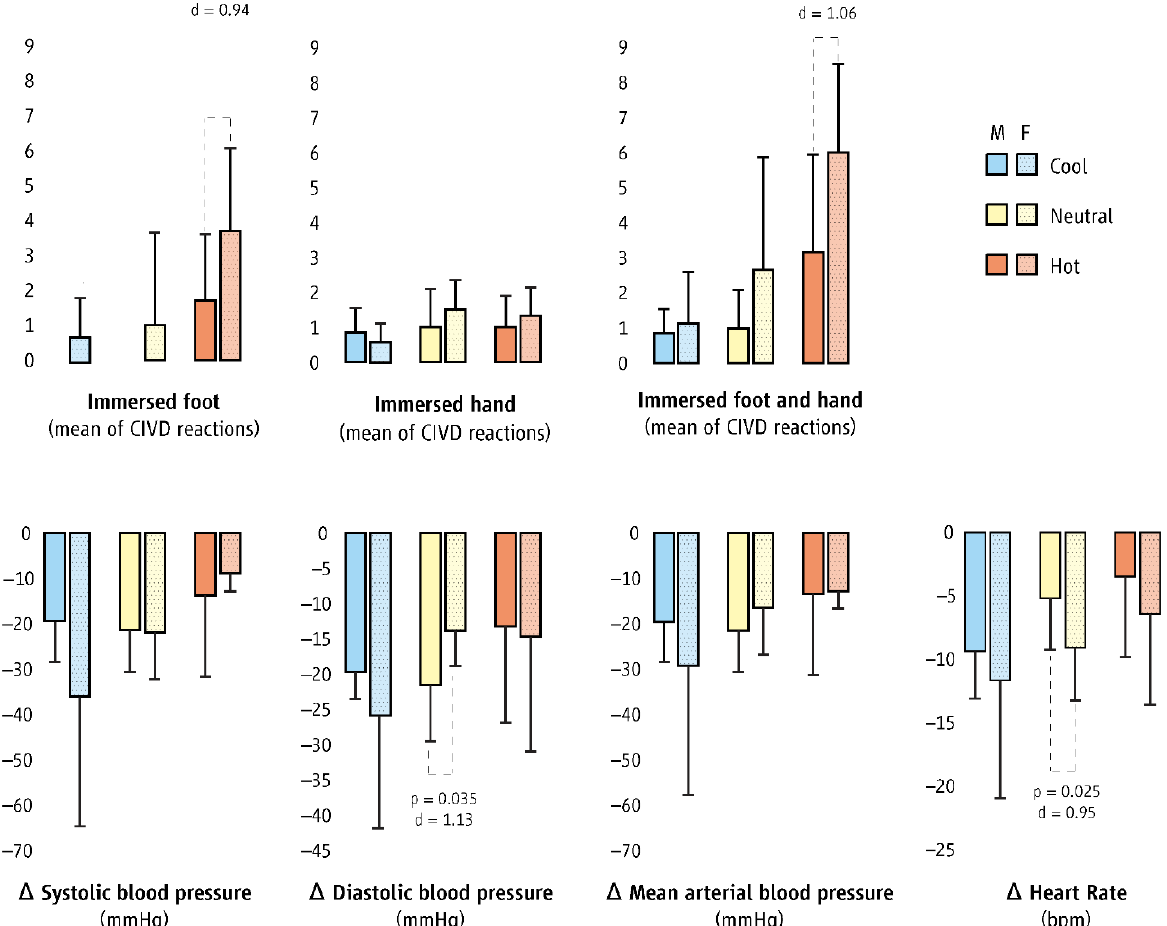
Figure 3. Differences (mean ± SD) between men (M) and women (F) in the occurrence of cold-induced vasodilation reactions (CIVD; top bars) and cardiovascular strain during the first minute of cold-water immersion (bottom bars) across cool (blue bars), thermoneutral (yellow bars), and hot (orange bars) environments. Cardiovascular strain during the first minute of cold-water immersion was expressed as the delta difference from the last minute of warm-water immersion and the first minute of cold-water immersion.